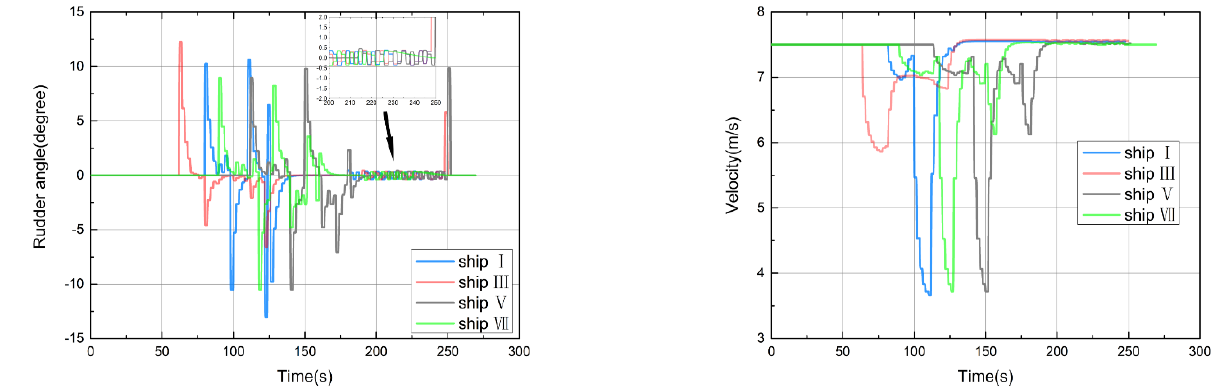
Figure 13. Rudder angle and velocity of ship I, III, V and VII.